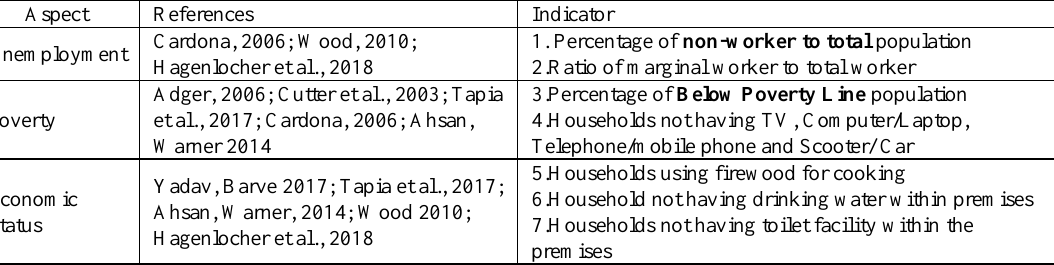
Table 2. Sub-dimensions, indicators and references for economic vulnerability.